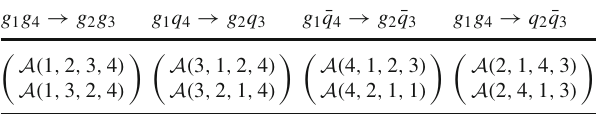
Table 3 Definitions of the vector of partial amplitudes (cid:4) A for all four- parton processes. The subscripts in the sub-process indication corre- spond to the momenta enumeration g 1 g 4 → g 2 g 3 g 1 q 4 → g 2 q 3 g 1 ¯ q 4 → g 2 ¯ q